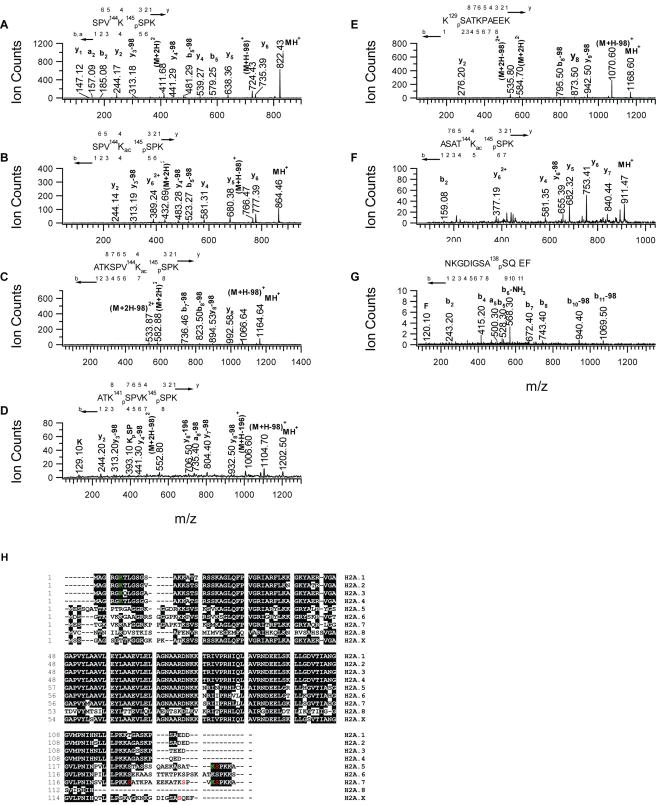
Identification of H2A modification sites.A. MS/MS spectrum of doubly-charged precursor ion at m/z 411.72 demonstrating phosphorylation at S145 in the peptide SPVK145
pSPK of H2A.7. B. MS/MS spectrum of doubly-charged precursor ion at m/z 432.69 demonstrating phosphorylation at S145 and acetylation at K144 in peptide SPV144Kac
145
pSPK of H2A.7. C. MS/MS spectrum of doubly-charged precursor ion at m/z 582.88 demonstrating phosphorylation at S145 and acetylation at K144 in peptide ATKSPV144Kac
145
pSPK of H2A.7. D. MS/MS spectrum of doubly-charged precursor ion at m/z 601.78 demonstrating phosphorylation at S141 and S145 in peptide ATK141
pSPVK145
pSPK of H2A.7. E. MS/MS spectrum of the doubly-charged precursor ion at m/z 584.80 demonstrating phosphorylation at S129 in peptide K129
pSATKPAEEK of H2A.7. F. MS/MS spectrum of the doubly-charged precursor ion at m/z 456.24 demonstrating phosphorylation at S145 and acetylation at K144 in the peptide ASAT144Kac
145
pSPK of H2A.5. G. MS/MS spectrum of the doubly-charged precursor ion at m/z 666.81 demonstrating phosphorylation at S138 in the peptide NKGDIGSA138
pSQEF of H2AX. H. Sequence alignment of H2A isoforms (H2A.1-H2A.8). K in green color: acetylation; S in red color: phosphorylation.